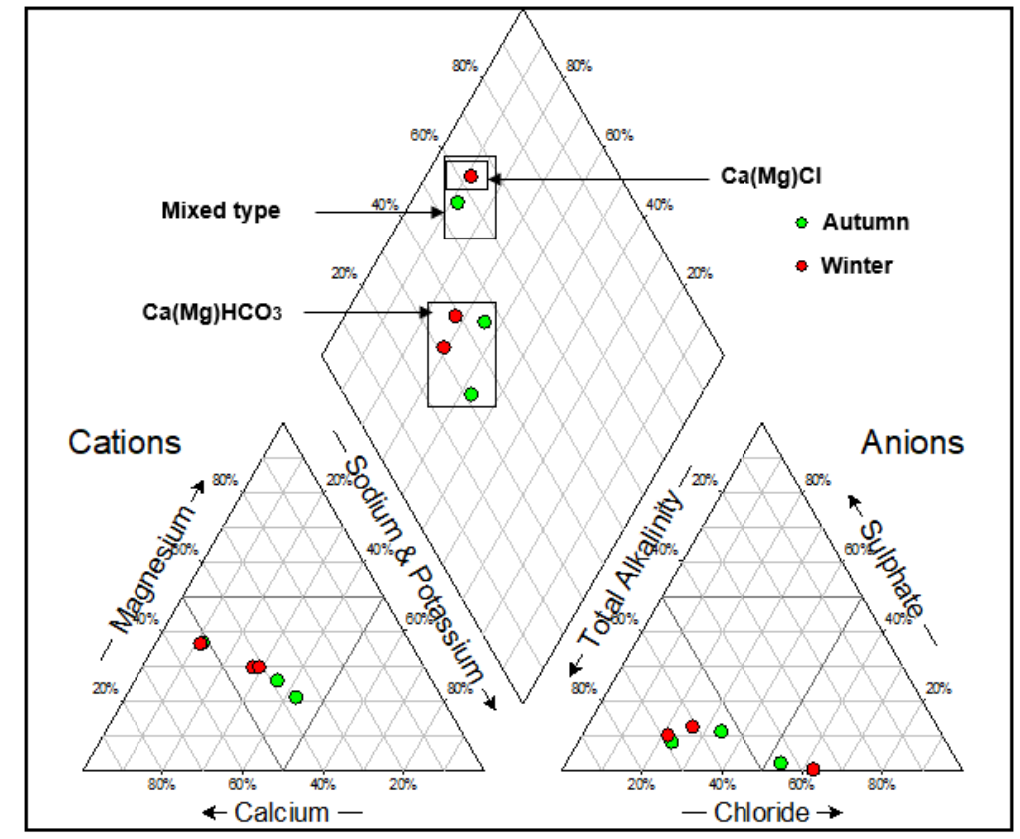
Figure 4. Piper diagram for the groundwater samples in the southern landfill site for the two seasons.